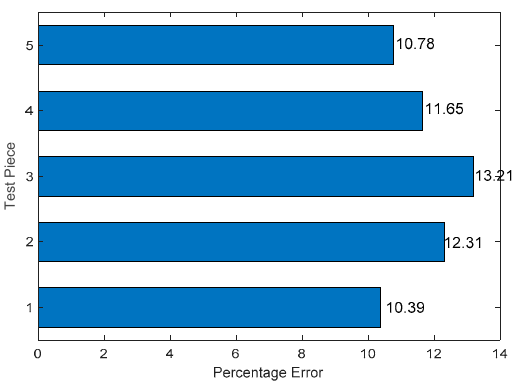
Figure 13. Percentage error of five test pieces.